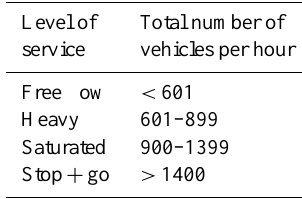
Table 2. Level of service as a function of total number of vehicles per hour based on Vägverket and SMHI